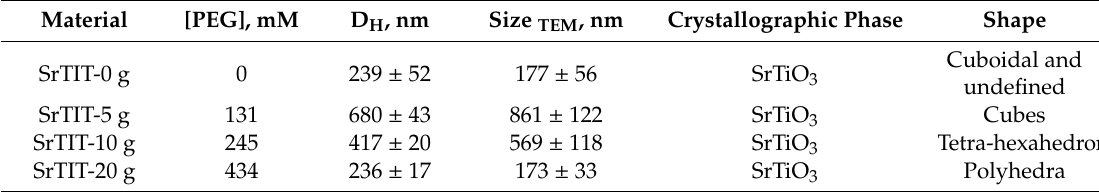
Table 1. Characteristics of the main synthesized materials.